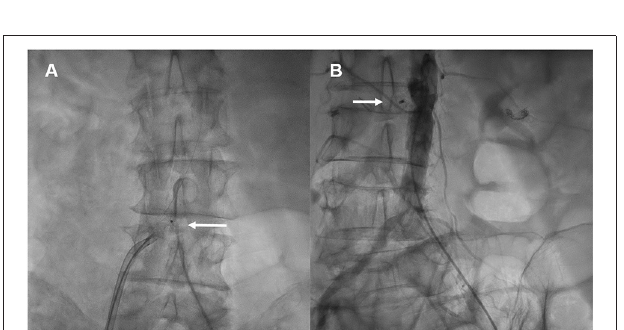
FIGURE 3 | Hemostasis of abdominal aorta puncture. The nitinol occluder is deployed at the aorta puncture site using contrast injections from a pigtail catheter in the abdominal aorta (A) , and utilizing a deflectable sheath which allows for co-axial deployment of the occluder ( A , Arrow). Once the occluder is positioned and released, a final aortogram is performed to verify successful hemostasis at the puncture site ( B , Arrow).